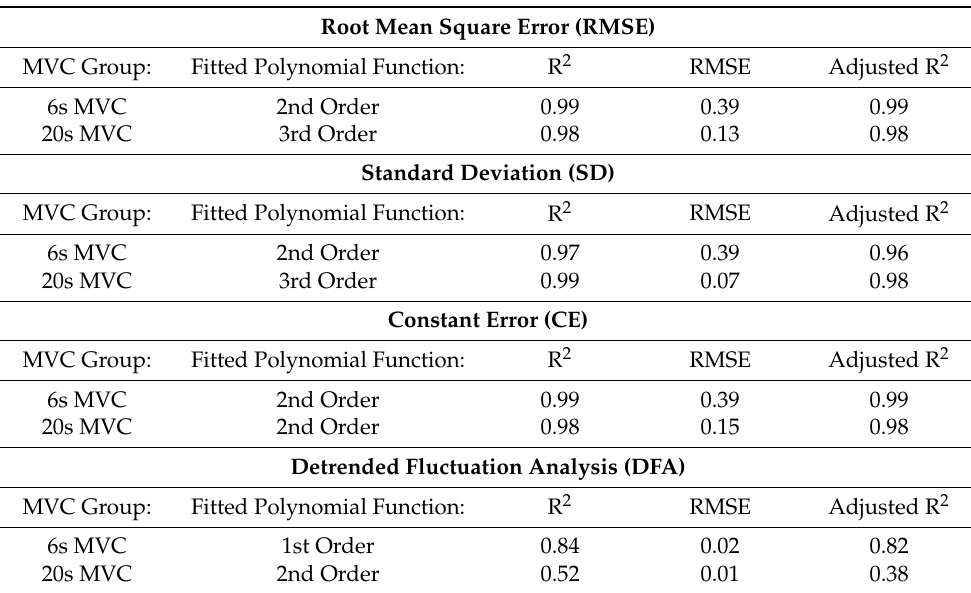
Figure 2. Fitted functions on averaged ( a ) RMSE, ( b ) SD, ( c ) CE, and ( d ) DFA as a function of MVC group and force level. Table 1. Fitted models for RMSE, SD, CE, and DFA as a function of relative force output (%MVC).